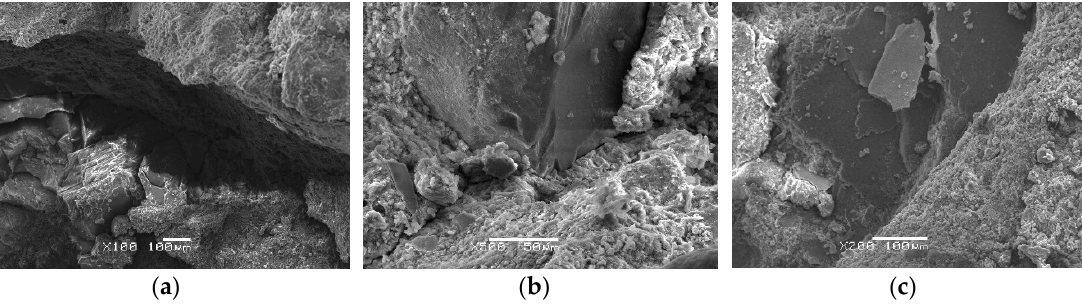
Figure 21. Interface between mortar and detritus: ( a ) w/c ratio: 0.68; ( b ) w/c ratio: 0.54; ( c ) w/c ratio: 0.44.